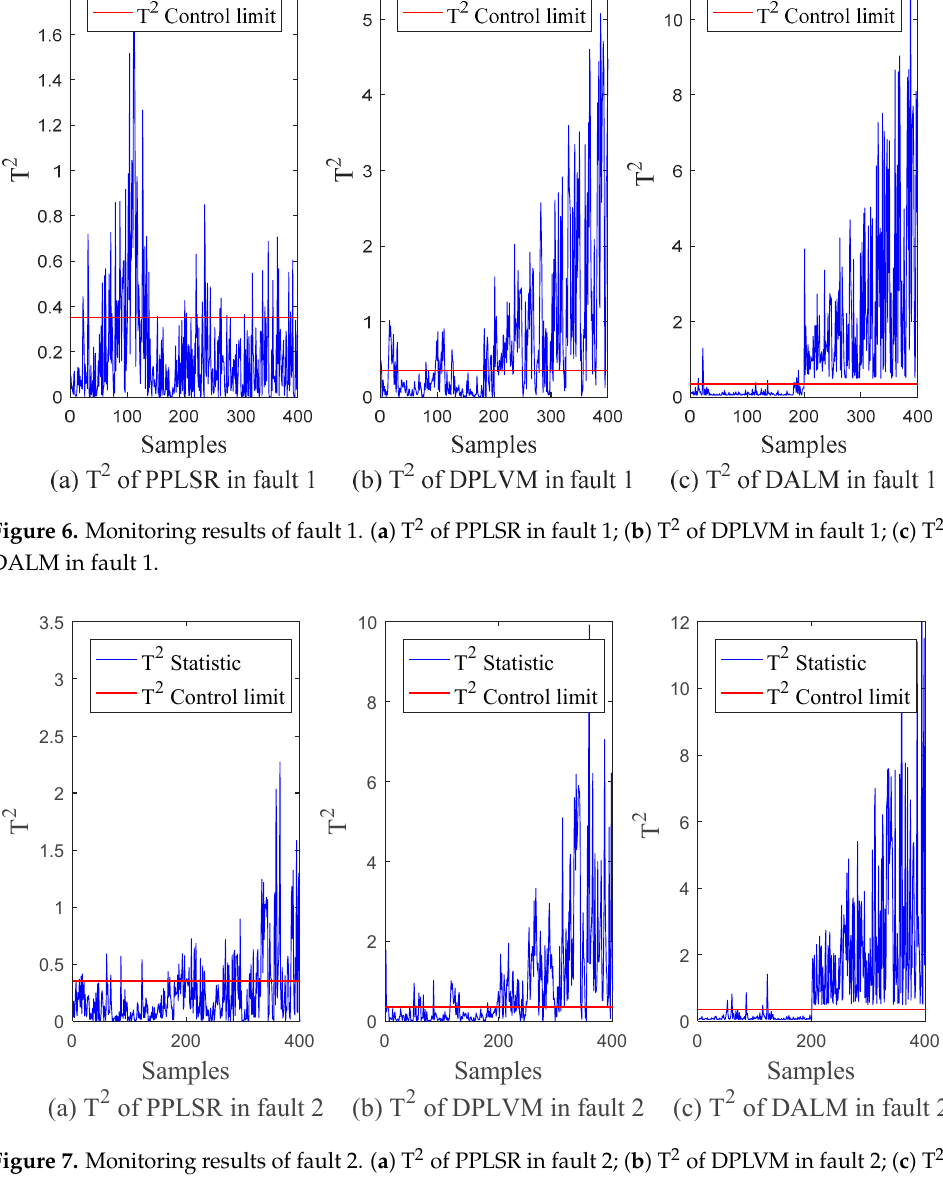
Figure 8. Monitoring results of fault 3. ( a ) T 2 of PPLSR in fault 3; ( b ) T 2 of DPLVM in fault 3; ( c ) T 2 of DALM in fault 3.